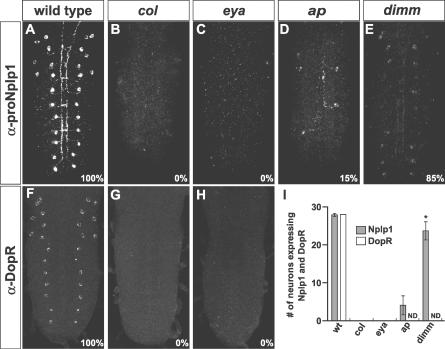

col and Other Ap Neuron Determinants Regulate Both Nplp1 and DopR(A–E) Expression of proNplp1 at 18 h AEL in wild type (A), col (B), eya (C), ap (D), and dimm (E) reveals a complete loss of expression in col and eya mutants, and a partial loss in ap and dimm mutants.(F–H) Expression of DopR in wild-type (F), col (G), and eya (H) mutants. Expression of DopR is completely lost in col and eya mutants.(I) Quantification of observed phenotypes (n > 10 VNCs). ND (not determined) denotes that DopR expression was not assayed in ap and dimm mutants because previous studies have already revealed a strong effect of ap and dimm on DopR expression [14]. The asterisk denotes that Nplp1 is significantly affected in dimm mutants (Student t-test, p < 0.01). wt, wild type.Genotypes: (A and F) w1118, (B and G) col1/col3, (C and H) eyaCli-IID/eya10, (D) app44, and (E) dimmp1/dimmrev4.